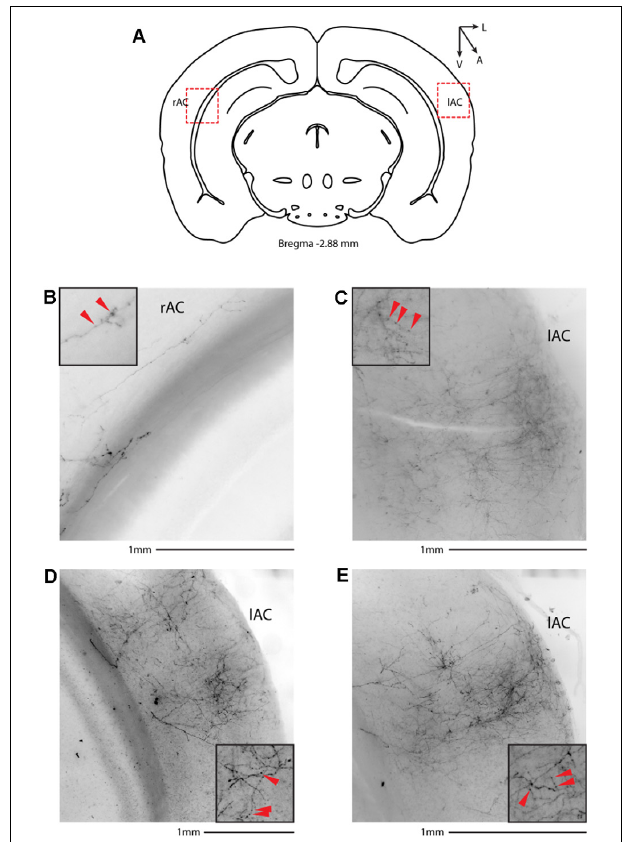
FIGURE 5 | Cortical target of long-range VIP-expressing neurons: auditory cortex. (A) Allen Brain reference coronal section at − 2.88 mm from Bregma. Red dashed squares indicate the regions imaged in the panels below. (B) Representative image of white matter infiltrating axons in correspondence to the injection site. (C–E) Three examples of contralateral auditory cortex from two animals. Scale bars: 1 mm. Insets indicate axonal branches and the red arrowheads boutons. Inset size 190 µ m. lAC, left auditory cortex; rAC, right auditory cortex.